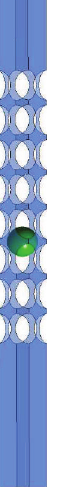
Figure 7: Typical